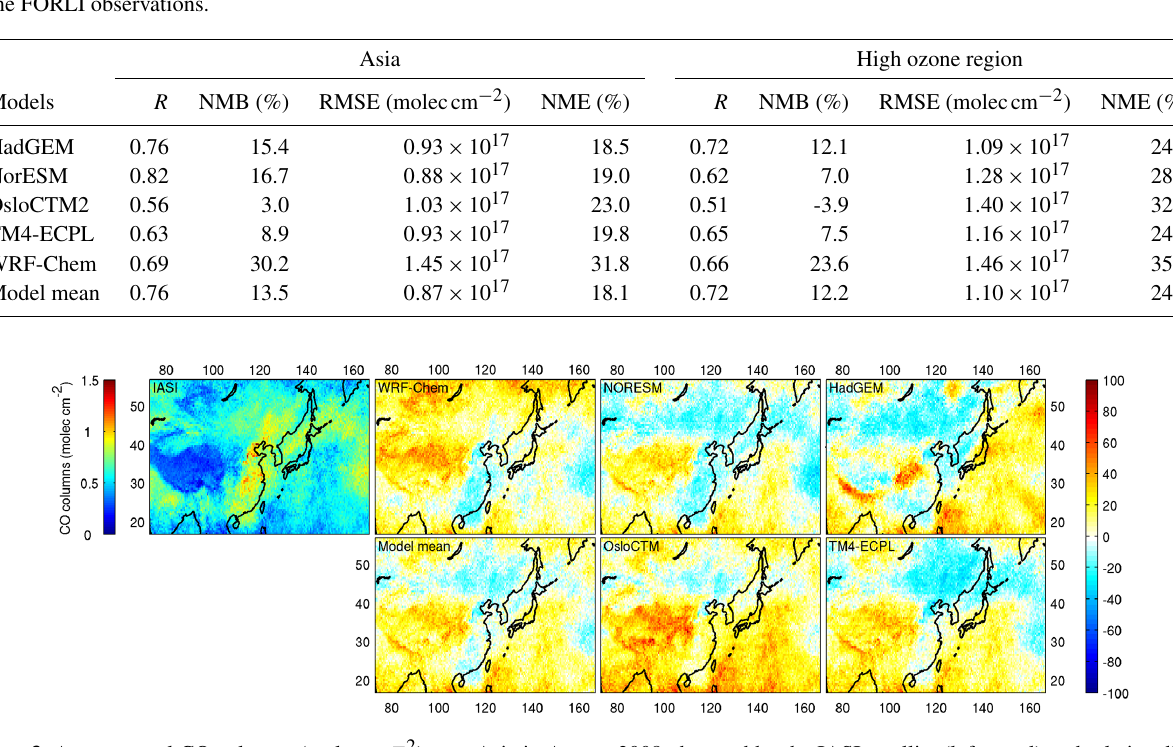
Figure 3. Average total CO columns (moleccm − 2 ) over Asia in August 2008 observed by the IASI satellite (left panel) and relative differ- ences between columns observed by IASI and simulated by the models as well as the model mean (models names are given in each relevant panel).